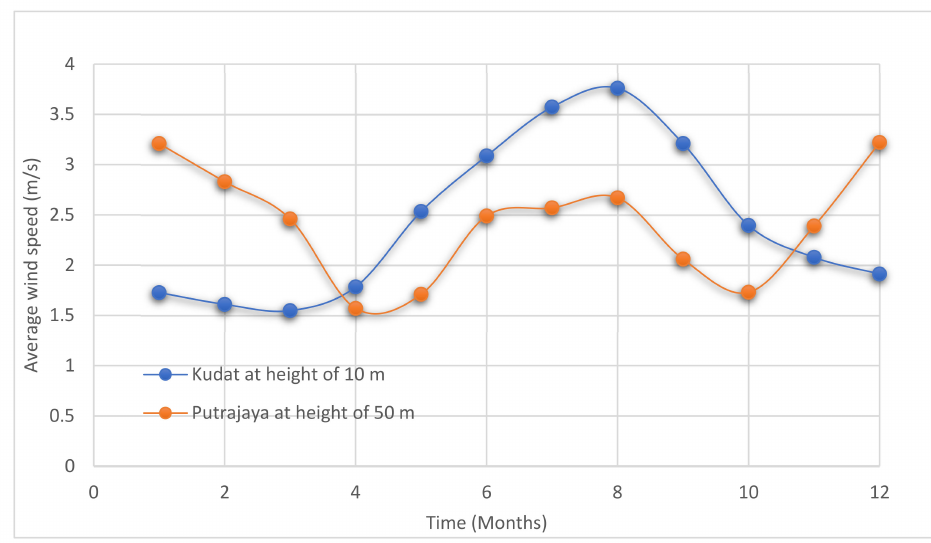
Figure 5. Average of wind speed profile in the selected sites.